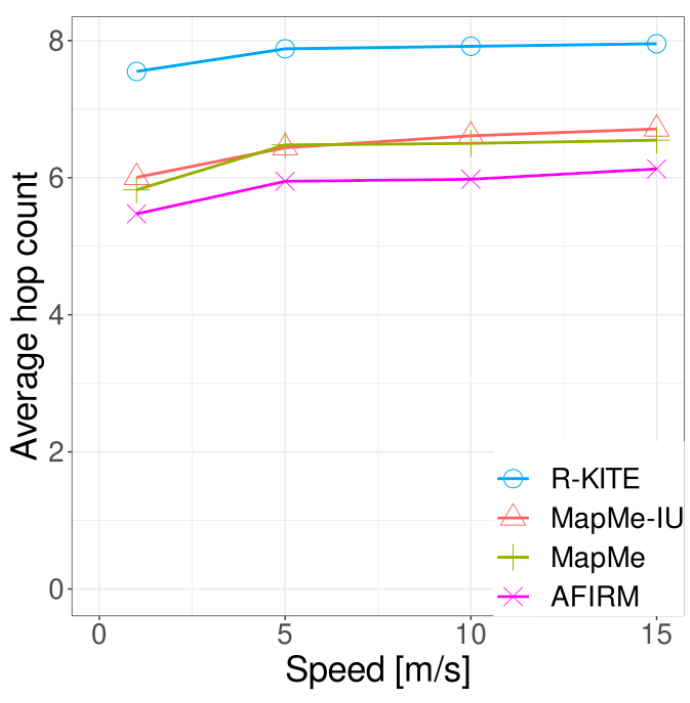
Figure 8. Average hop